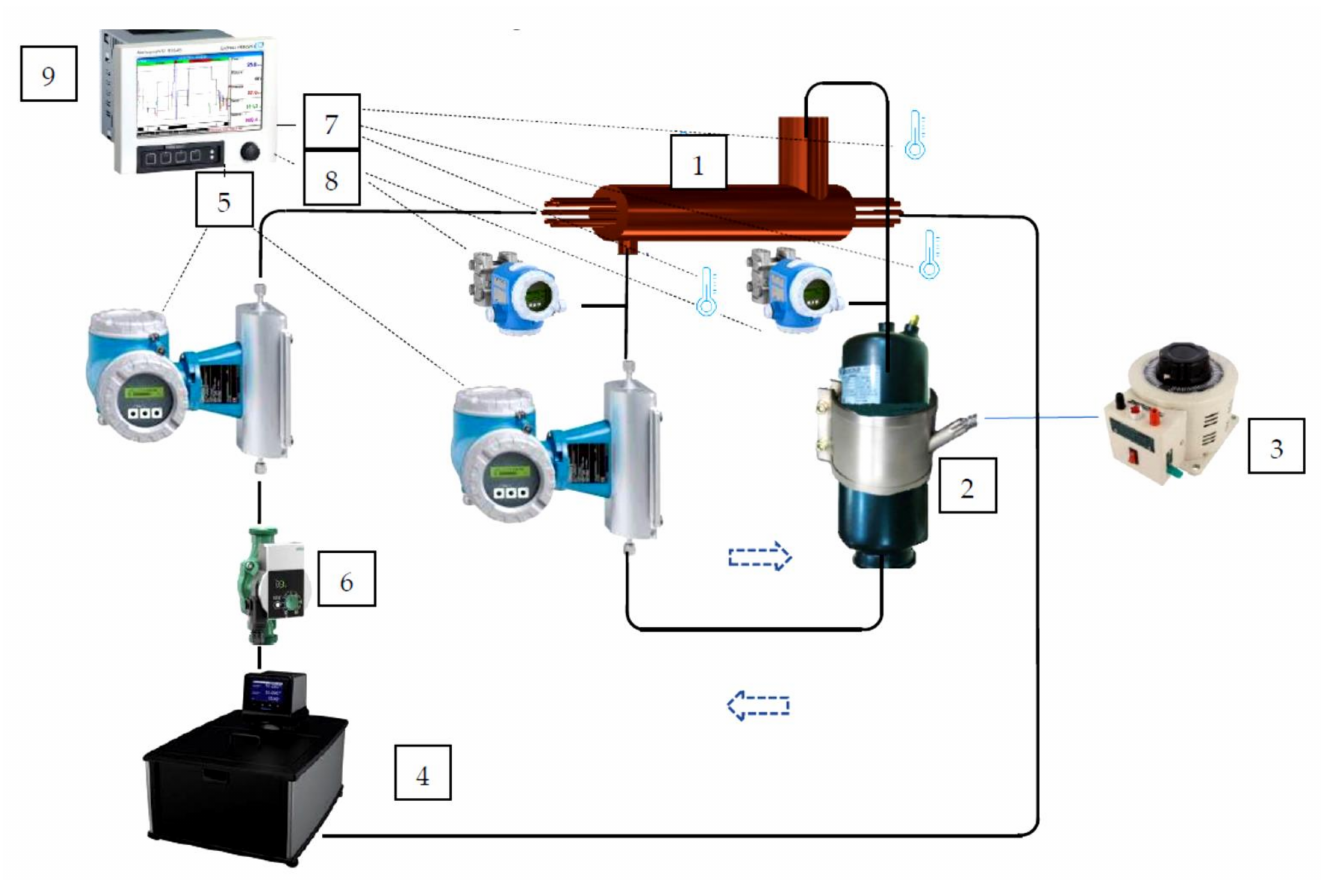
Figure 1. Pictorial diagram of the measuring stand: 1—heat exchanger; 2—refrigerant tank; 3—autotransformer; 4—cryostat; 5—mass flow meter; 6—circulation pump; 7—K-type thermocouple; 8—pressure sensor; 9—recording